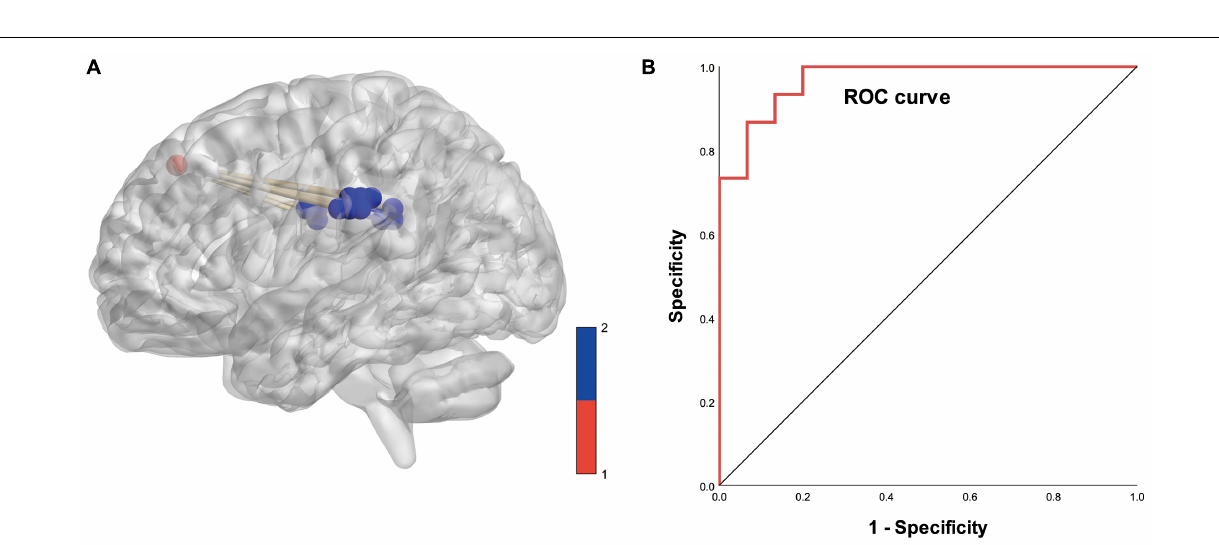
Frontiers in Neuroscience |